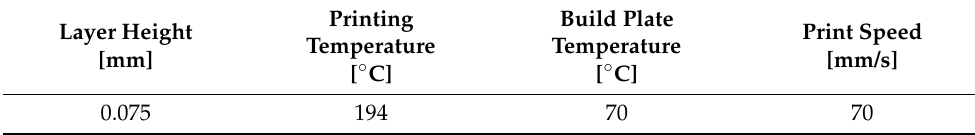
Table 1. FDM printing settings for GhostIce (Paperdifferent, Marghera, VE, Italy).